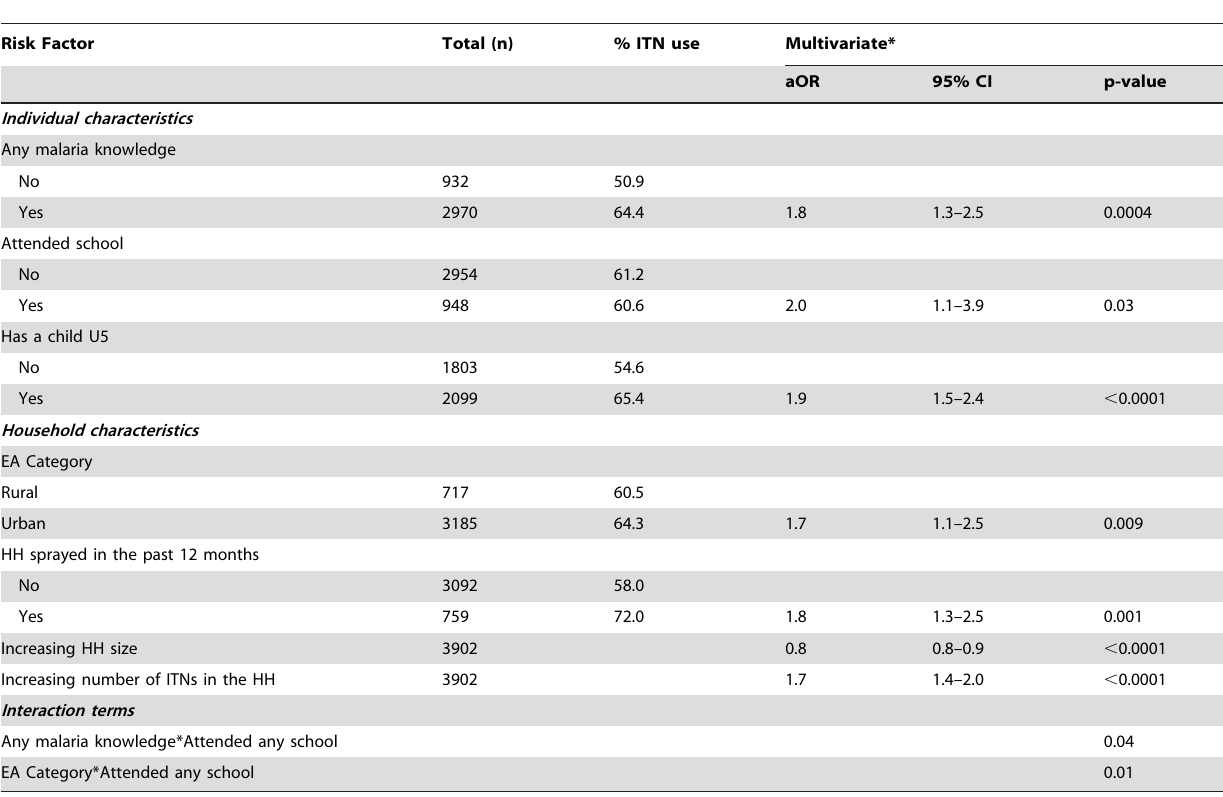
Table 5. Women’s knowledge of malaria as it predicts their ITN use in households that own at least one ITN.